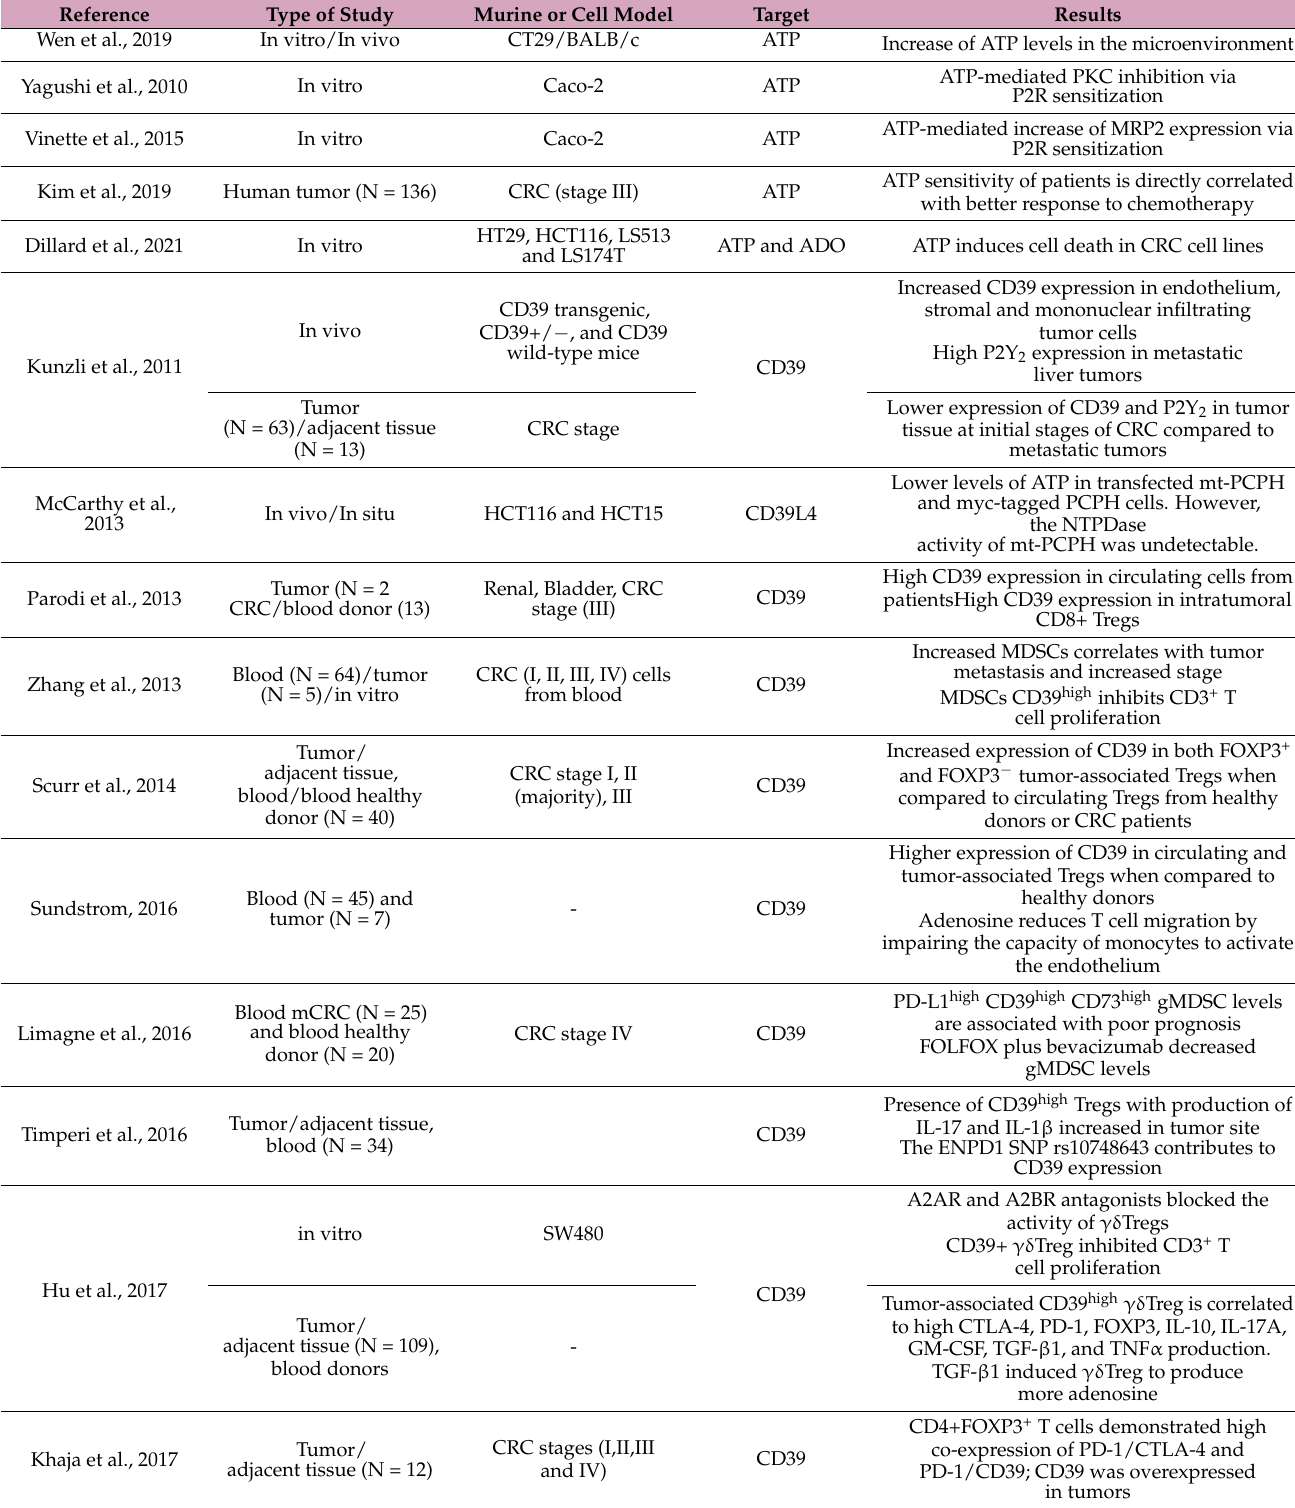
Table 1. Overview of purinergic signaling participation on colorectal cancer biology—preclinical and clinical